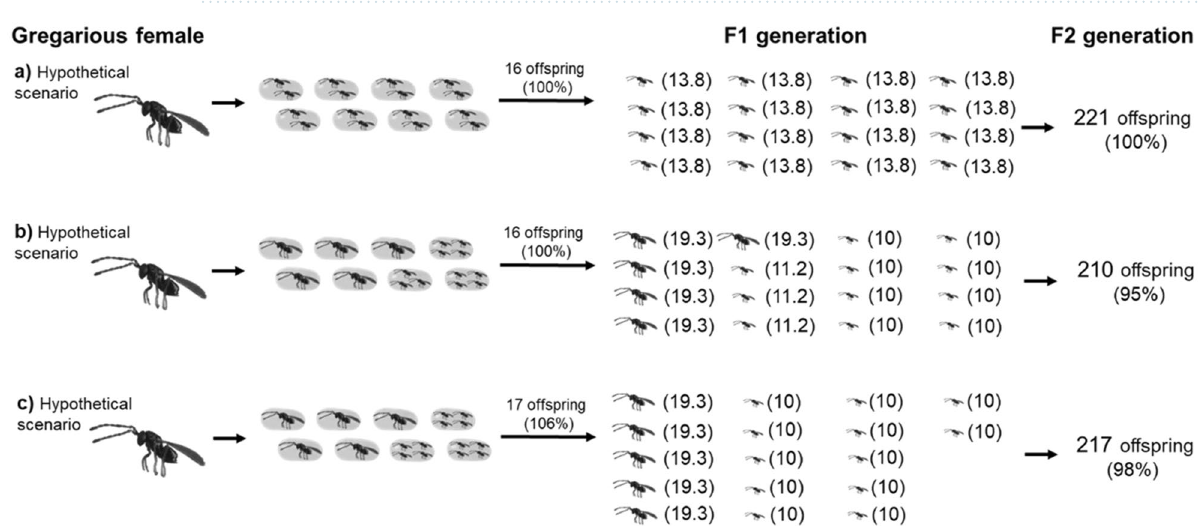
Figure 2. The different fertility values obtained in the F2 generation of females with the same number of host eggs and the same ( a , b ) or different fertility values in the F1 generation ( c ) (to simplify the model, the fertility values (shown in parentheses) are rounded (explained in “Methods” section); male offspring are not shown, explained in detail in the “Methods” section Exp.